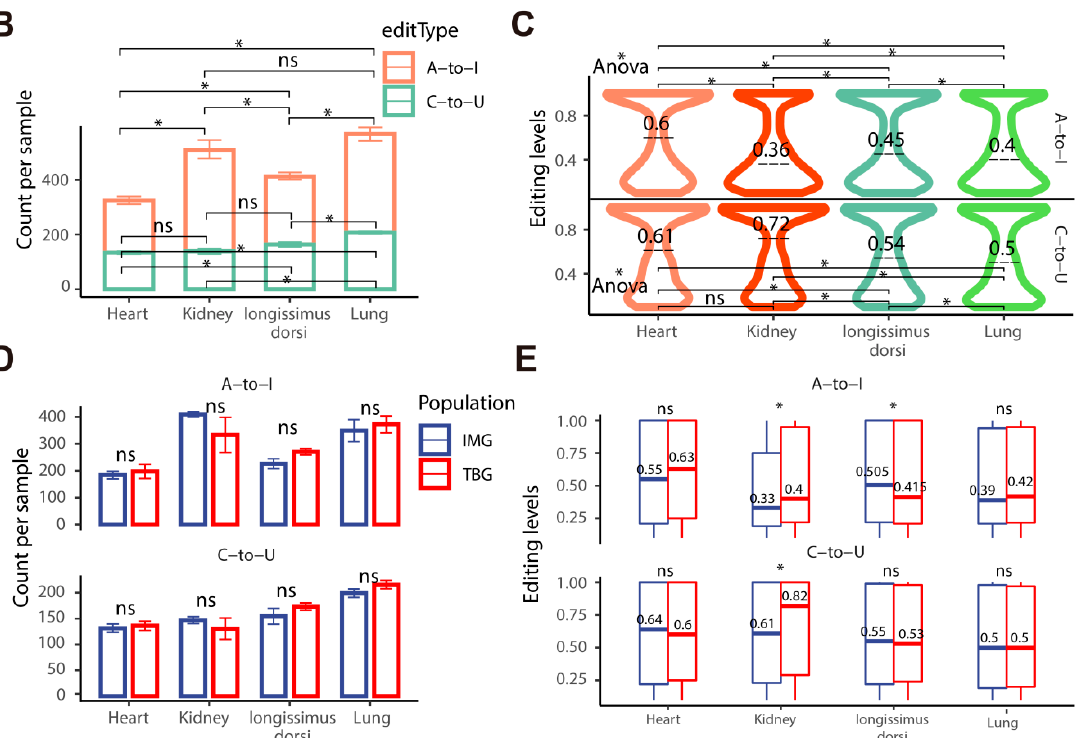
Figure 4. The numbers and editing levels of RESs across goat tissues and populations. ( A ) The numbers of A-to-I and C-to-U editing sites across tissues and populations. ( B ) The numbers of A-to-I and C-to-U editing sites per sample across tissues. ( C ) Distribution of A-to-I and C-to-U editing levels across tissues. ( D ) The numbers of A-to-I and C-to-U editing sites per sample between TBG and IMG populations. ( E ) The editing levels of A-to-I and C-to-U editing sites between TBG and IMG populations. TBG: Tibetan cashmere goats, IMG: Inner Mongolia cashmere goats, ns, no significant difference ( p > 0.05), * p <